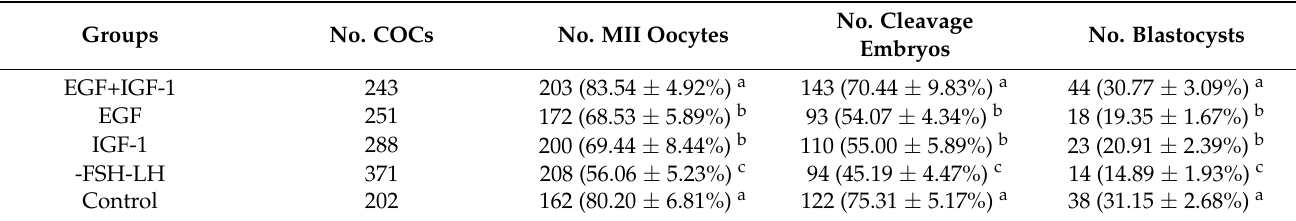
Table 3. Effect of EGF and IGF-1 on the maturation and development ability of bovine oocytes without